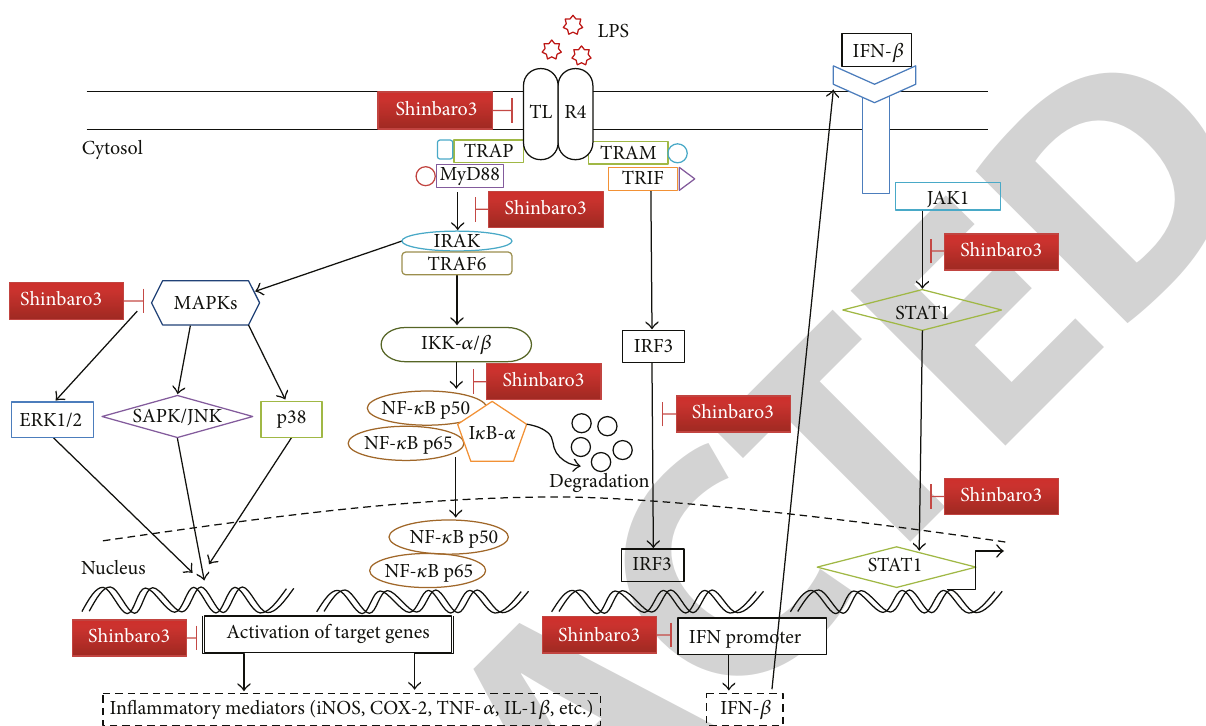
Figure 8: Overview of the TLR4 signalling pathway. The mechanisms underlying the inhibitory e ff ects of Shinbaro3 on the LPS-induced in fl ammatory